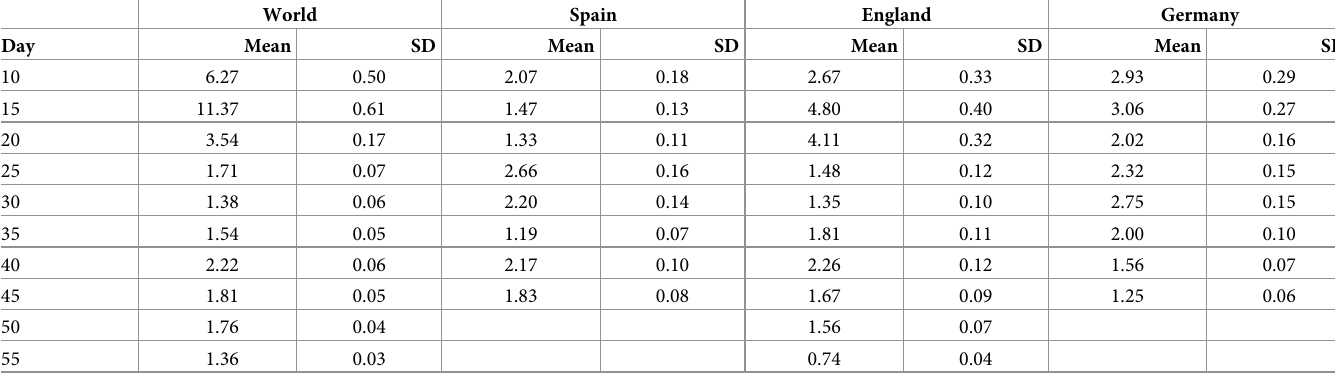
Table 2. Estimated effective reproduction number for the 2022 MPX outbreak using method from [83] on MPX reported cases data from [85].